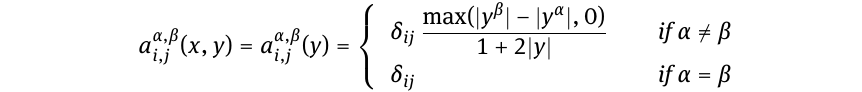
Fig. 1: Assumption ( A 3 ) : off-diagonal coefficients a α , β the grey